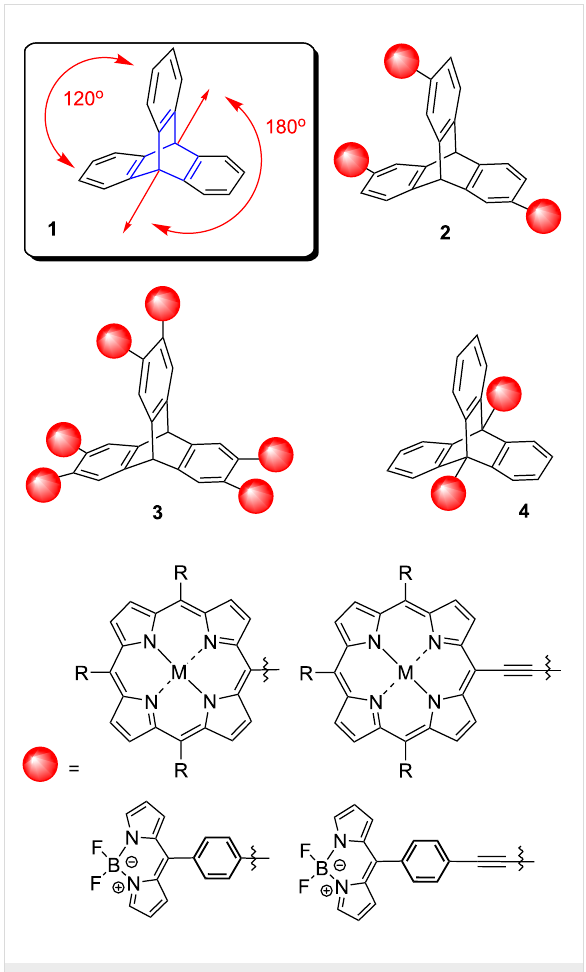
Figure 1: Triptycene as a scaffold and selected porphyrin and BODIPY